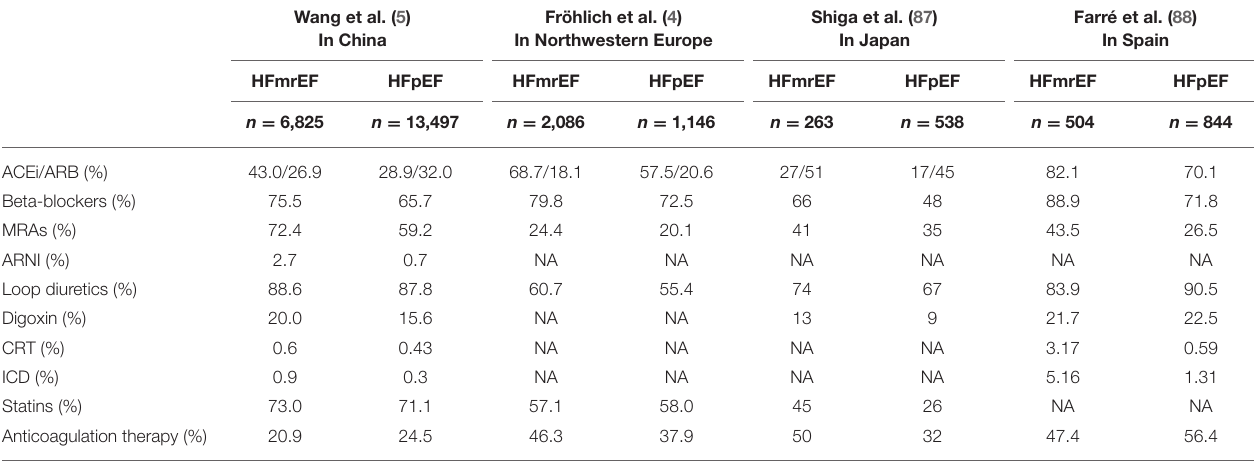
TABLE 3 | Common treatment of patients with HFmrEF and